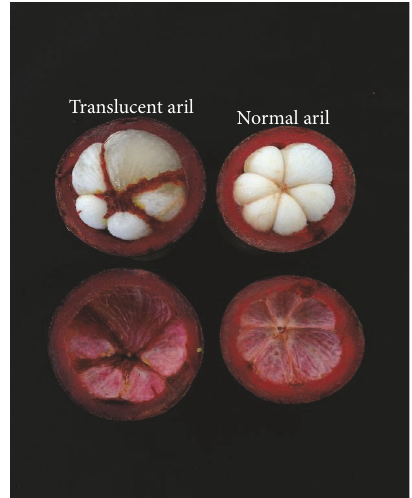
Figure 2: Character of normal ripe and translucent disorder arils in mangosteen